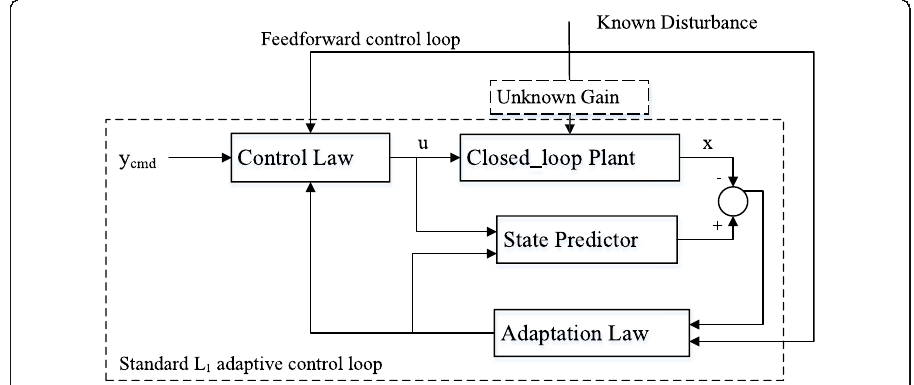
Fig. 2 Block diagram of the structure of L 1 adaptive control with feedforward control